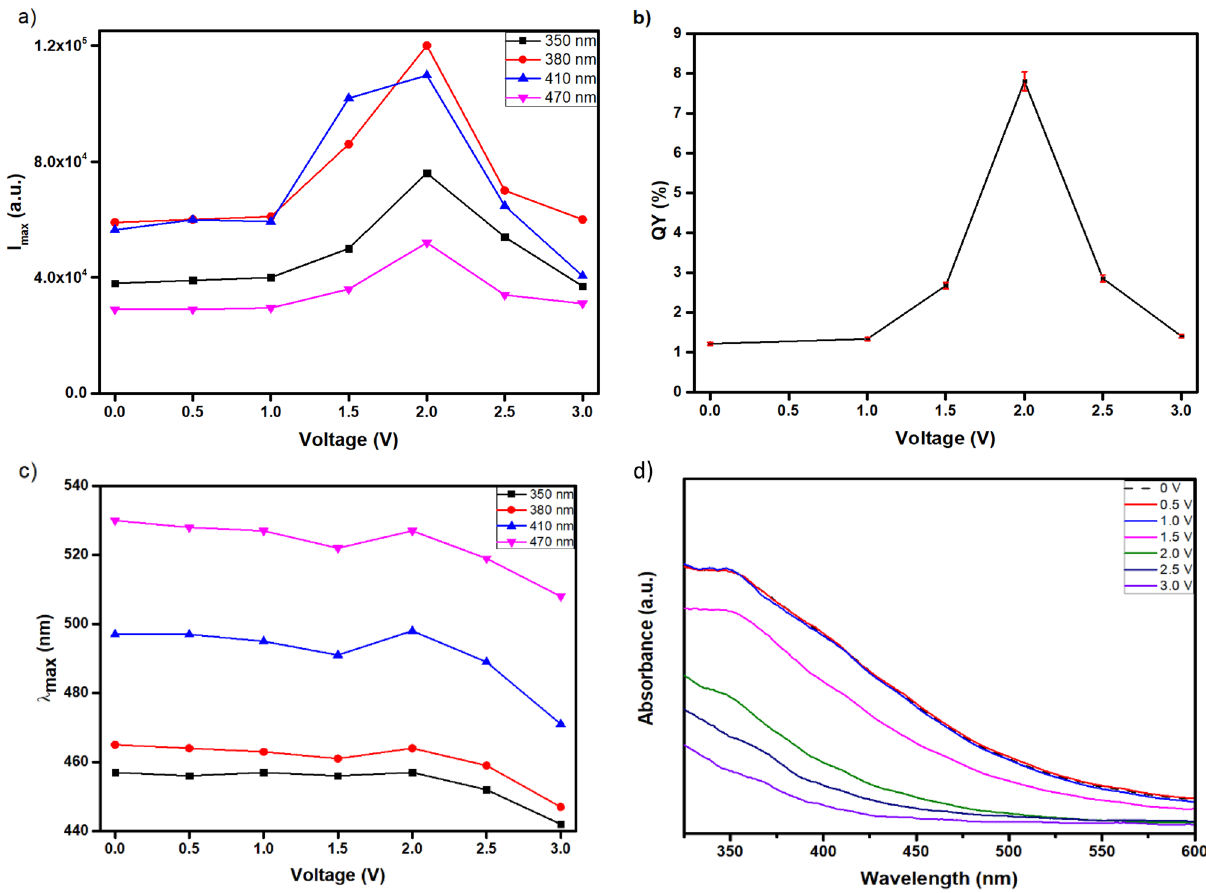
Figure 2. 0.02 mg ml –1 C-dots dispersion in 0.15 M KCl that has been subjected to chronoamperometry treatments for 60 s within applied voltage from 0.5 to 3.0 V compared to the untreated dispersion. ( a ) Maximum PL intensity (I